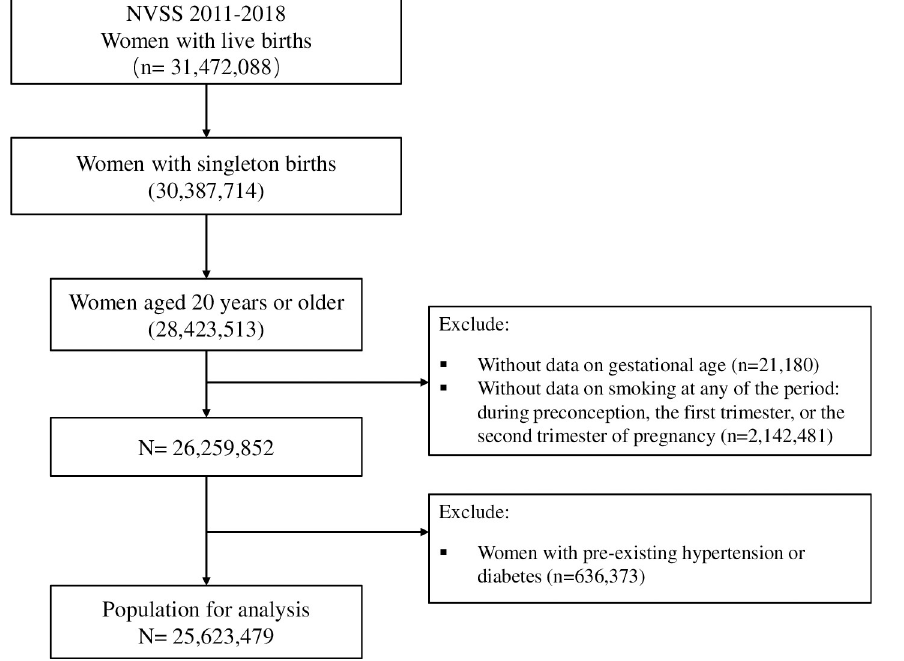
Fig 1. Participant flow chart. NVSS, National Vital Statistics